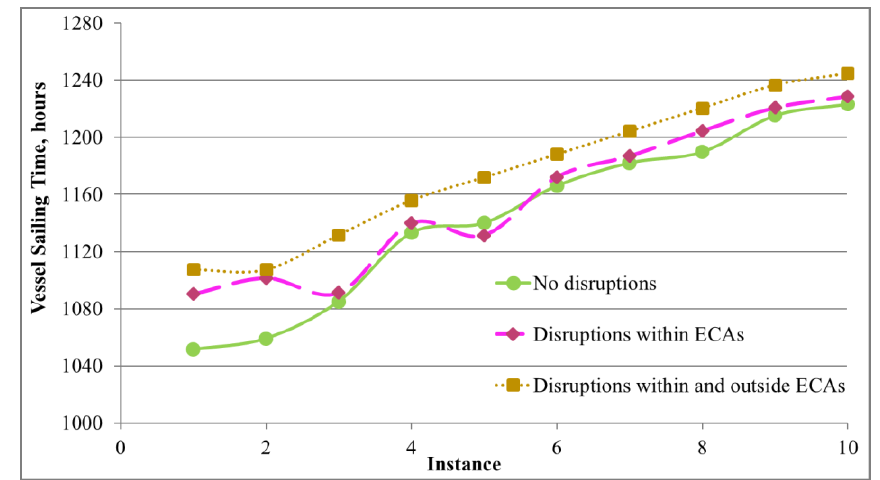
Figure 9. The total vessel sailing time for the considered problem instances.